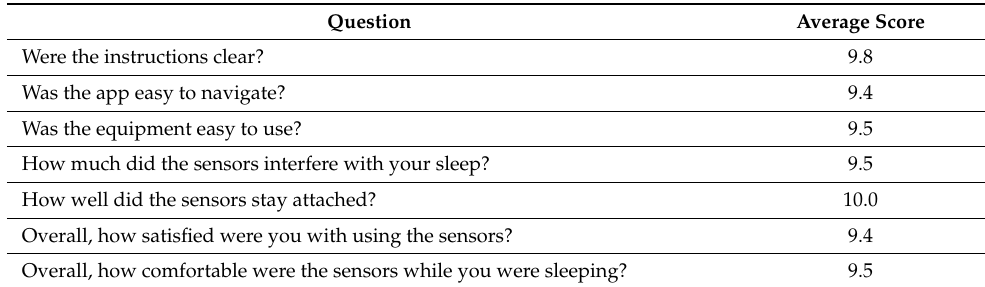
Table 3. Results of Participant Comfort Survey.